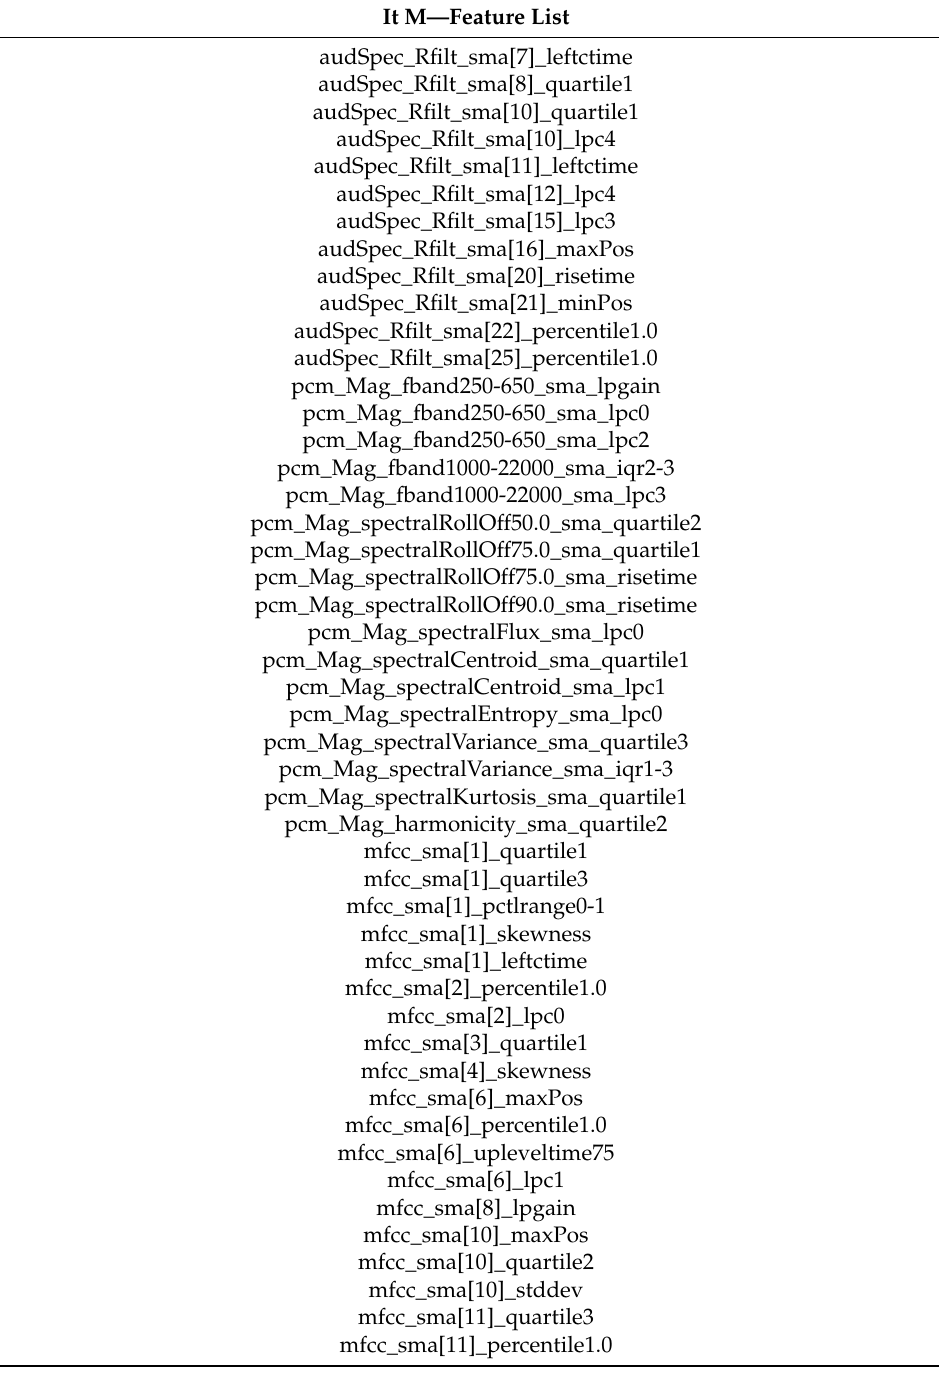
Table A1. Feature list for the It M classification task. Please note that numbers in square brackets are not references, but refer to the number of the window for the specific